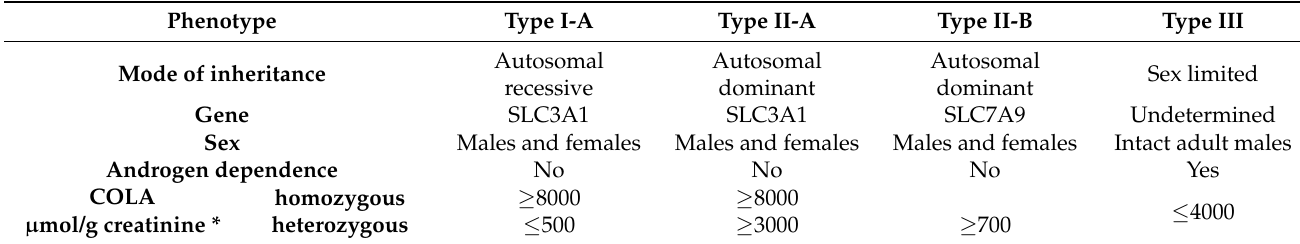
Table 1. Classification system for cystinuria according to Brons et al. 2013